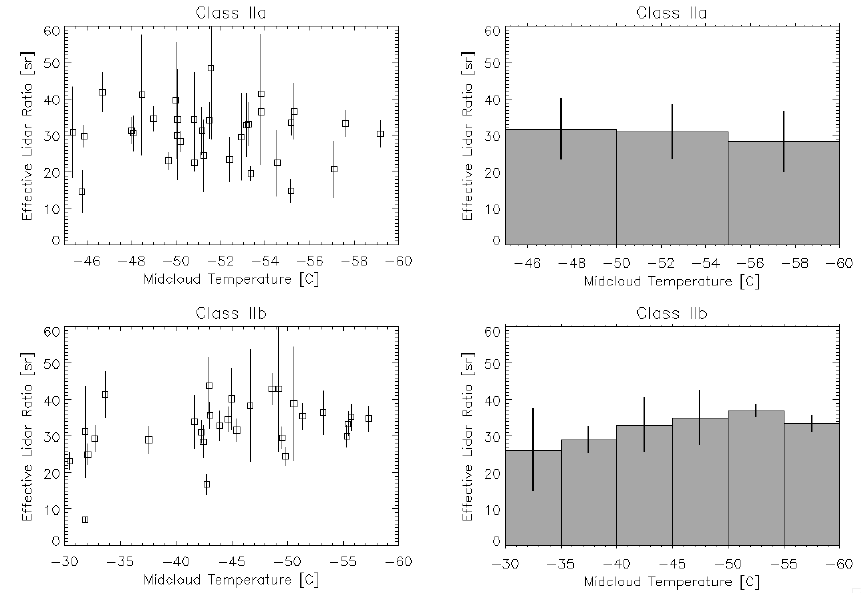
Fig. 6. Effective LR as function of midcloud temperature for classes IIa and IIb (first and second rows, respectively). In the first column, single LR values together with their uncertainties (black vertical lines) are plotted with respect to midcloud temperature, while the second column represents the frequency distributions of LR-weighted means with respect to midcloud temperature intervals of 5K. The black vertical lines are the uncertainties of the single values and the standard deviations of the weighted means (first and second columns, respectively).